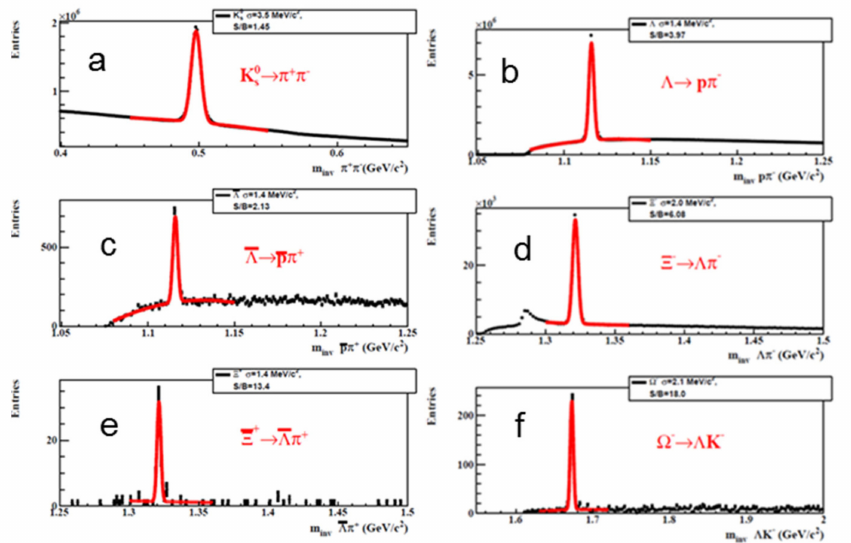
Figure 7. Reconstructed invariant mass distribution of K 0 ( a ), Λ ( b ), anti- Λ ( c ), Ξ − ( d ), Ξ + ( e ) and Ω − ( f ) in central Au + Au collisions at a beam energy of 11A GeV. The red lines indicate the signal together with the background fit by a polynomial plus Gaussian functions. The signal width, the signal-to-background ratio and the total reconstruction efficiency are indicated [50].